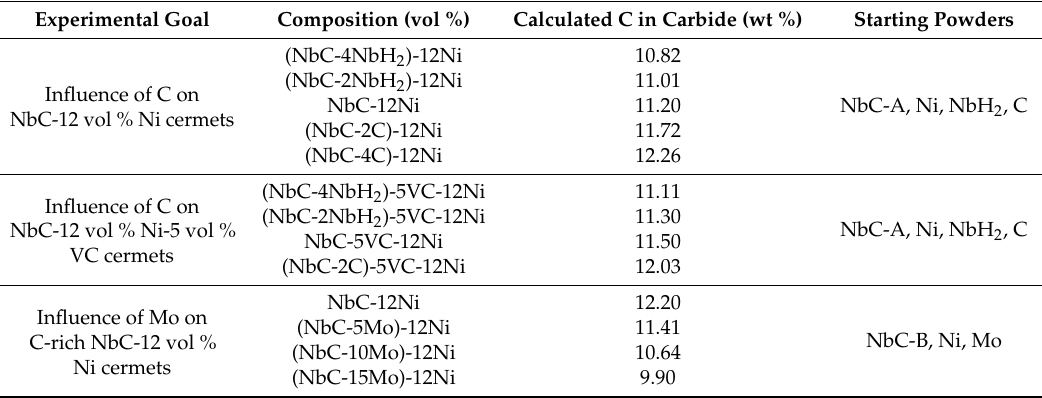
Table 2. Chemical composition of the investigated NbC-Ni based